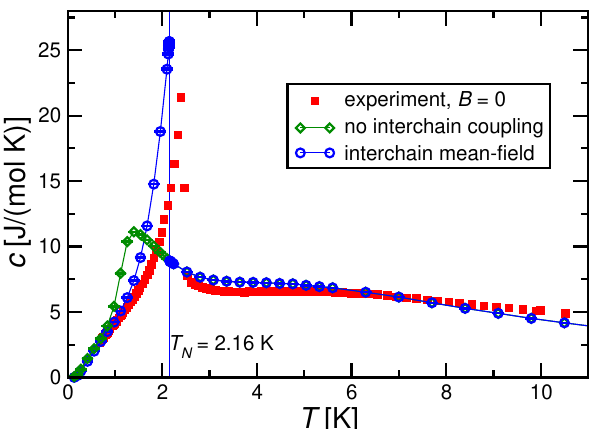
Figure 10. Magnetic specific heat per spin c for J = 2.8 K, D = 0.36 K in zero magnetic field h = 0 in comparison with the experimental results for B = 0. Theoretical results are obtained by QMC with N = 100 both for decoupled chains ( J ⊥ = 0) and with a self-consistent mean-field treatment for J ⊥ = − 0.072 K.